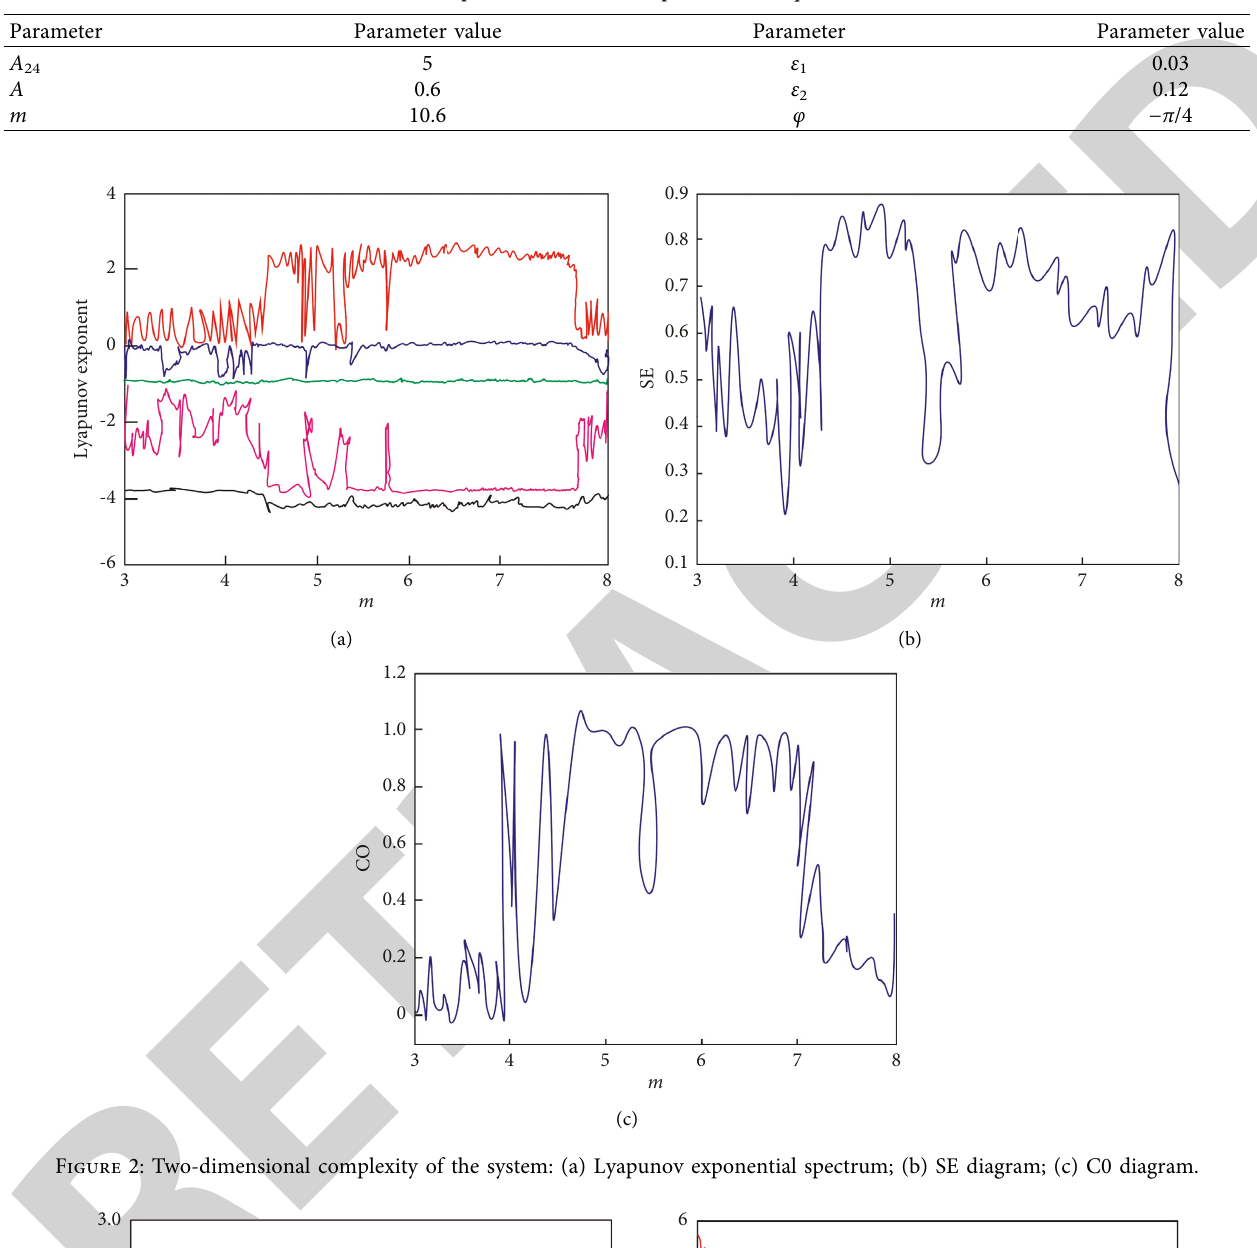
Table 1: The values of other parameters when the parameters c , q , and n take different values.